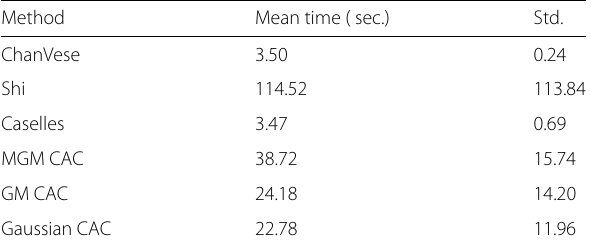
Table 2 Comparison of computational time of the CAC energies with other related methods in 300 × 225 images